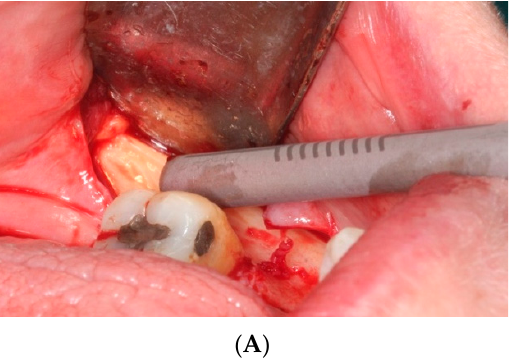
Figure 3. ( A ) Passivation of the lingual flap. ( B ) Checking the titanium mesh. Figure 4. ( A ) Obtaining autologous bone from the mandibular ramus. ( B ) Perforations in the man- dibular bone with a #6 tungsten carbide bur.